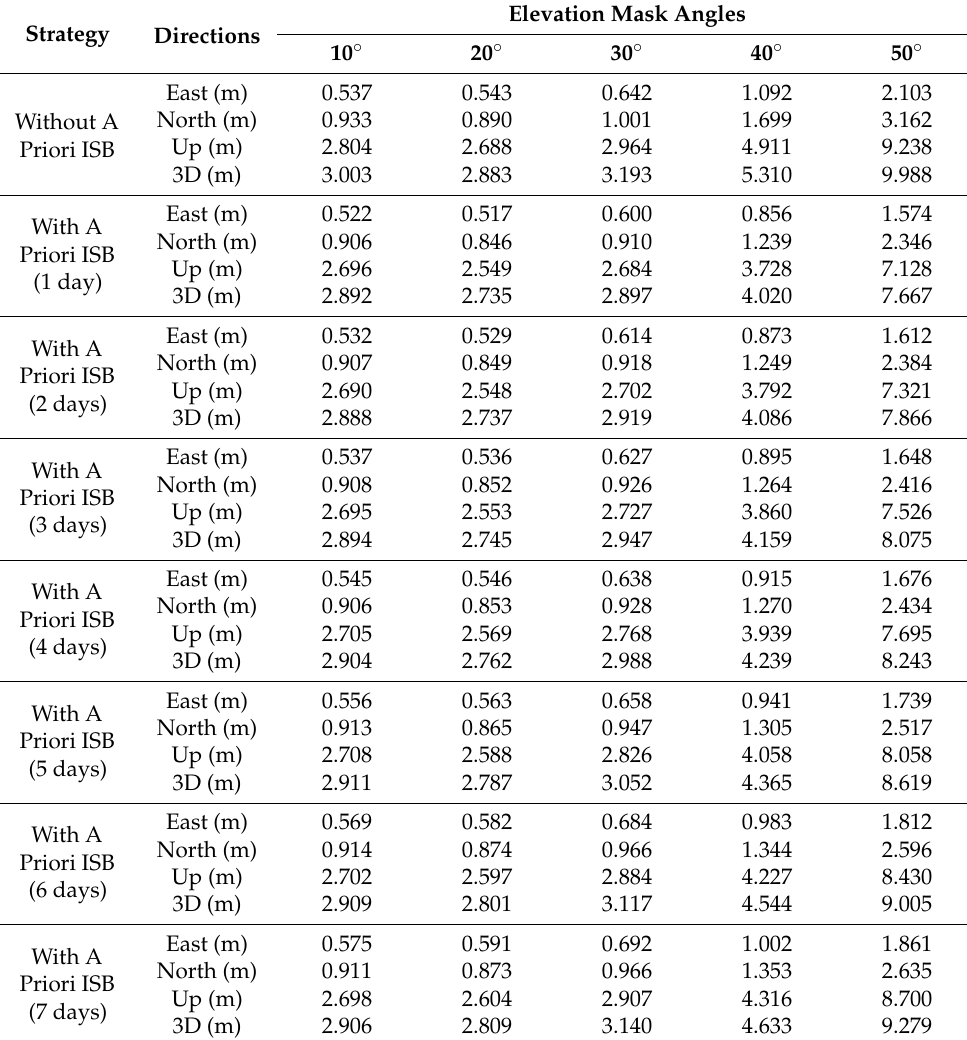
Table 4. Positioning accuracy in (m) of four-system integrated SPP with and without a priori ISB constraints under different elevation